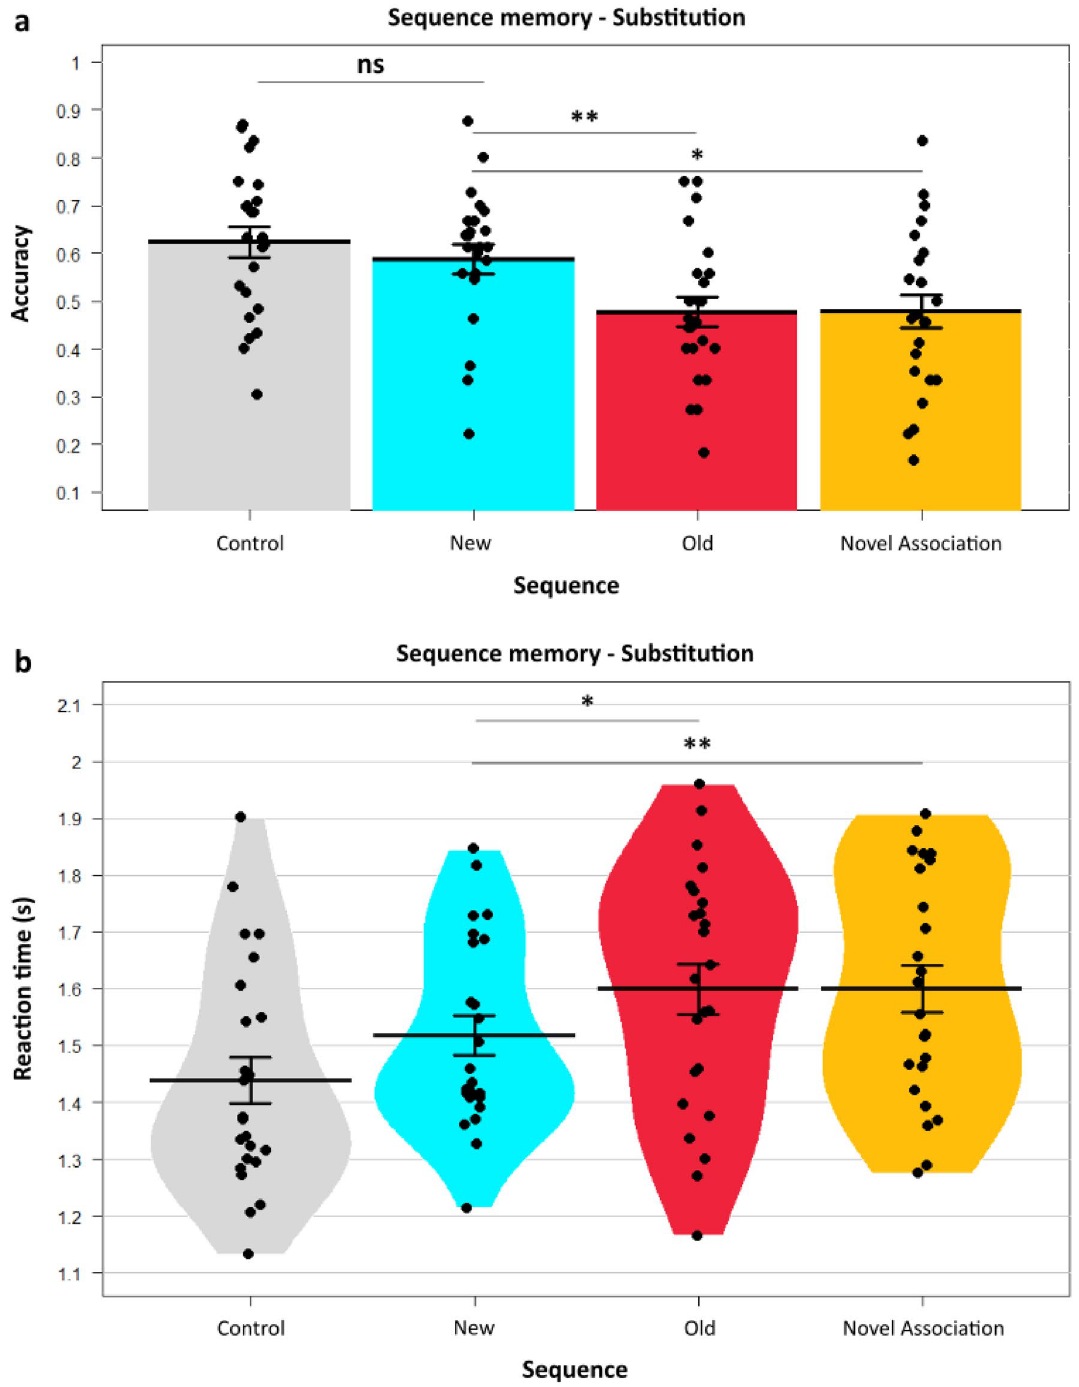
Figure 2. Effect of prediction errors on temporal order memory in substitution. In Substitution , New event is formed after a prediction error (surprise), when participants were expecting a previous sequence (Old). ( a ) Memory accuracy performance showing a significant difference between New and Old sequence for temporal order judgement. No significant difference in accuracy between New and Control sequences was observed. ( b ) Reaction time data reflecting the main result of accuracy between New and Old sequence. Dots represent participants’ individual performance ( n = 24). Error bars denote